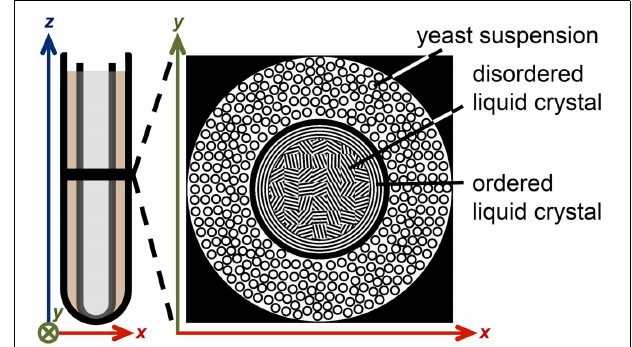
FIGURE 3 | Illustration of the liquid crystal/yeast MRI phantom. A 5mm NMR tube, containing 40 wt% of the surfactant C 10 E 3 in water, is inserted into a 10mm NMR tube with yeast cells in water. The black horizontal line in the left schematic indicates the slice of the 2D MR image. The top view of the phantom is depicted on the right . The anisotropic liquid crystal domains are mostly randomly oriented, while a narrow layer of aligned domains is formed near the tube